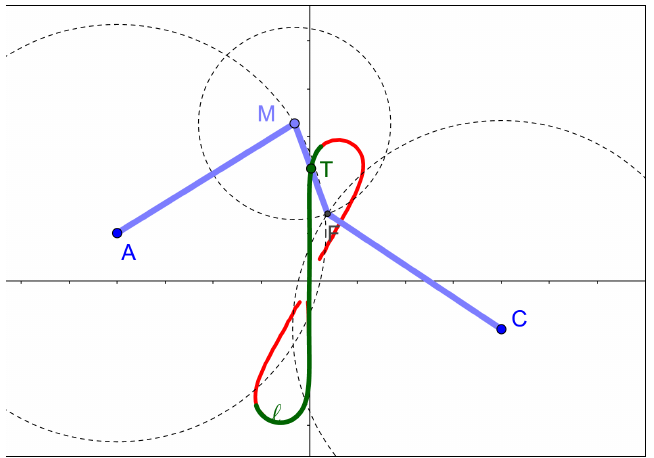
Figure 13. The Watt’s linkage, showing in green the swept branch of the geometric